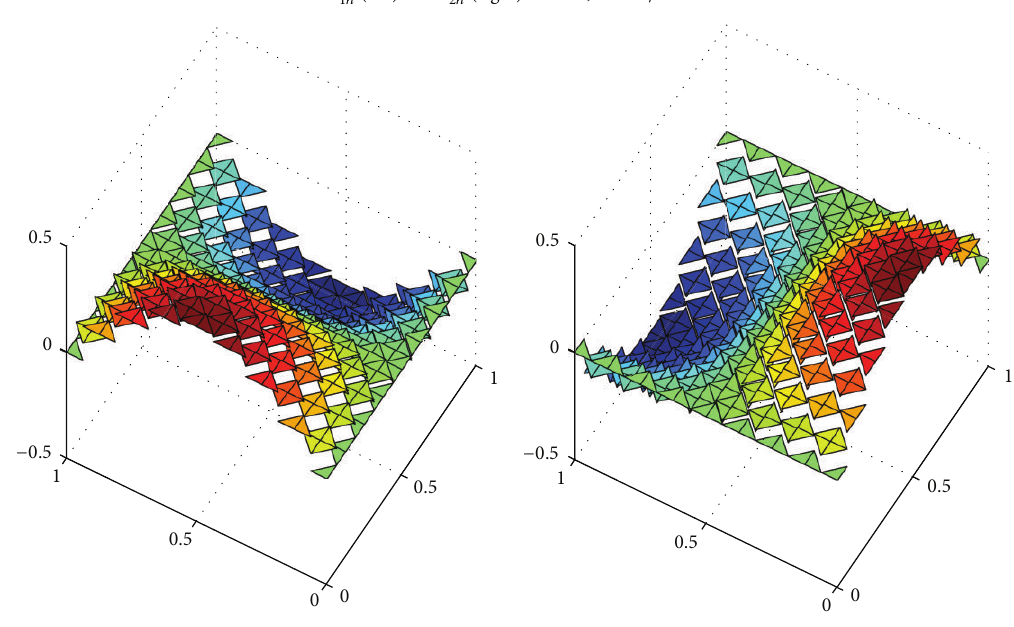
Figure 6: Surface for numerical solution 𝜆 ℎ = ( 𝜆 1ℎ , 𝜆 2ℎ )